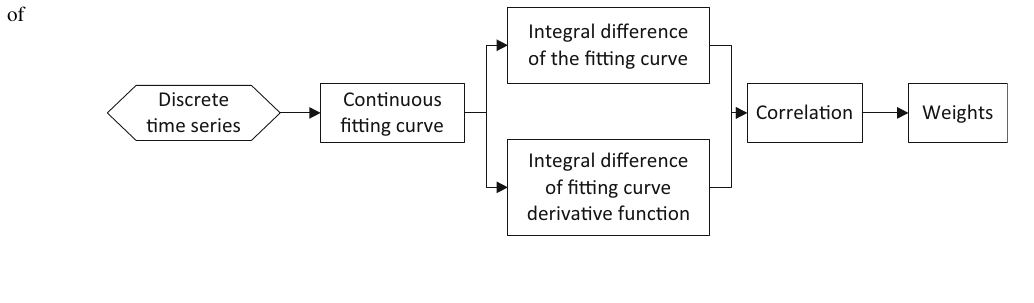
Fig. 2 Improved thinking